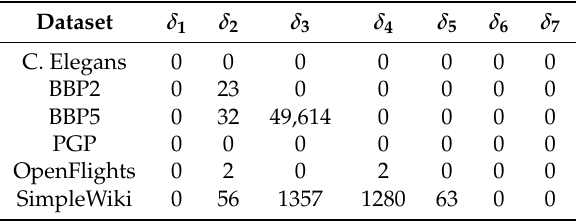
Table 8. The precise number of columns skipped in the F LAGSER computations presented in Table 7. The notation δ i refers to the i -th coboundary